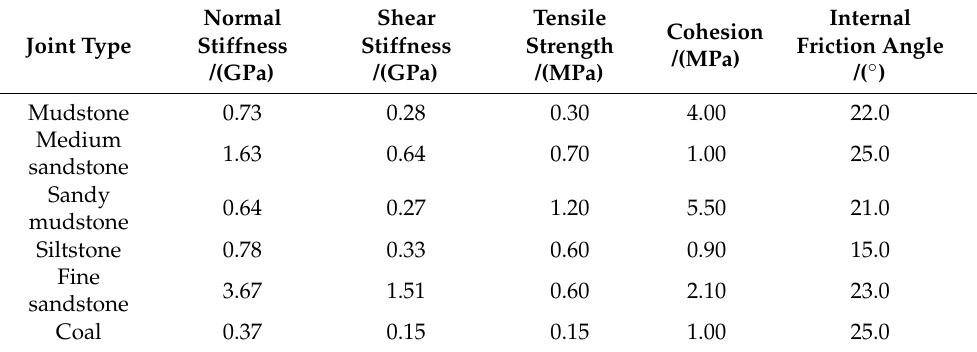
Table 3. Mechanical parameters of